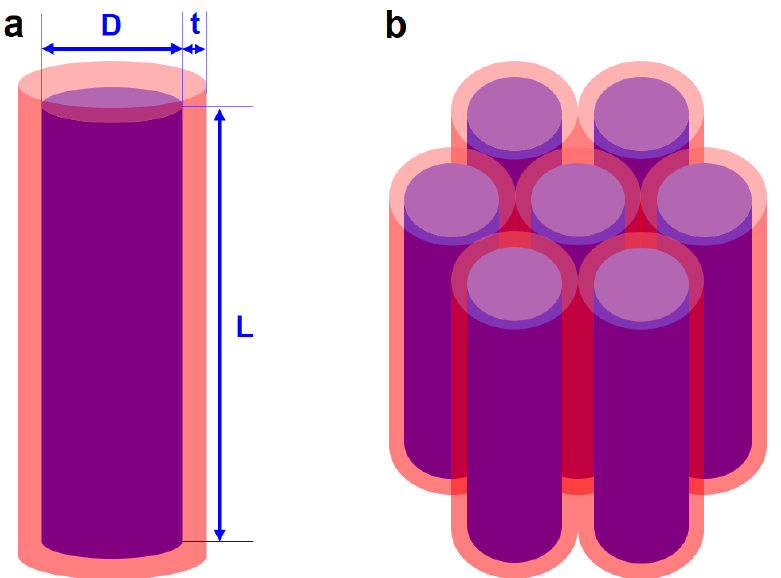
Figure 1. ( a ) Schematic illustration of the cylindrical core/shell structure. The outer shell represents the soft magnetic phase with thickness t , while the inner core represents the hard magnetic phase with diameter D and length L . ( b ) Schematic illustration of the hexagonal close-packed cylindrical array. The applied field and easy axis of the hard magnetic phase are parallel to the cylinder axis.